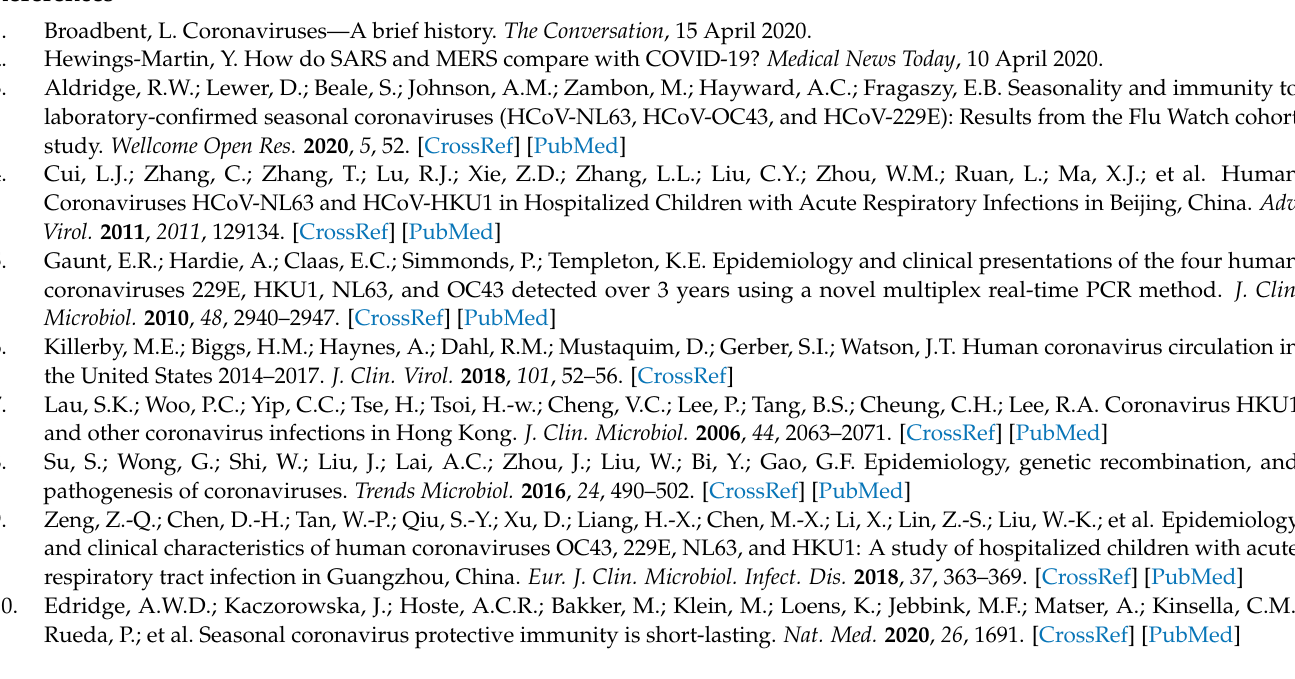
the covariance matrix value of the human (h) coronavirus (CoV) envelope (E) proteins for SARS- CoV-1, -2, MERS-CoV, HCoV-229E, and HCoV-NL63 based on the projection of two eigenvectors; Figure S3: The C-terminals of the SARS-CoV-1, -2, and MERS-CoV envelope (E) protein models superimposed onto the C-terminals of the experimentally resolved SARS-CoV-1 and 2 E proteins; Figure S4: Deuterium order parameters of the sn-1 and sn-2 chains of the carbon acyl chains of the 1-palmitoyl-2-oleoylphosphatidylcholine (POPC) simulated lipid bilayer for the five human (h) coronavirus (CoV) envelope (E) protein systems; Figure S5: Interactions between the PDZ-binding motif (PBM) of the SARS-CoV-2 envelope (E) protein and the 1-palmitoyl-2-oleoylphosphatidylcholine (POPC) lipids in the simulated lipid bilayer; Figure S6: Interaction between the PDZ-binding motif (PBM) of the HCoV-NL63 envelope (E) protein and the 1-palmitoyl-2-oleoylphosphatidylcholine (POPC) lipids in the simulated lipid